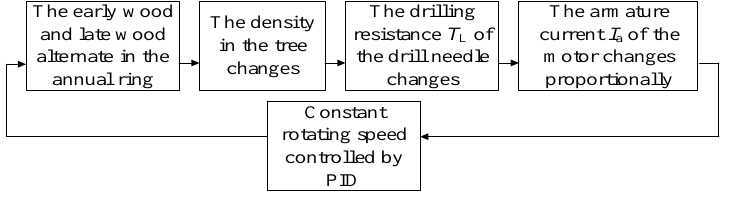
Figure 1. The working principle diagram.